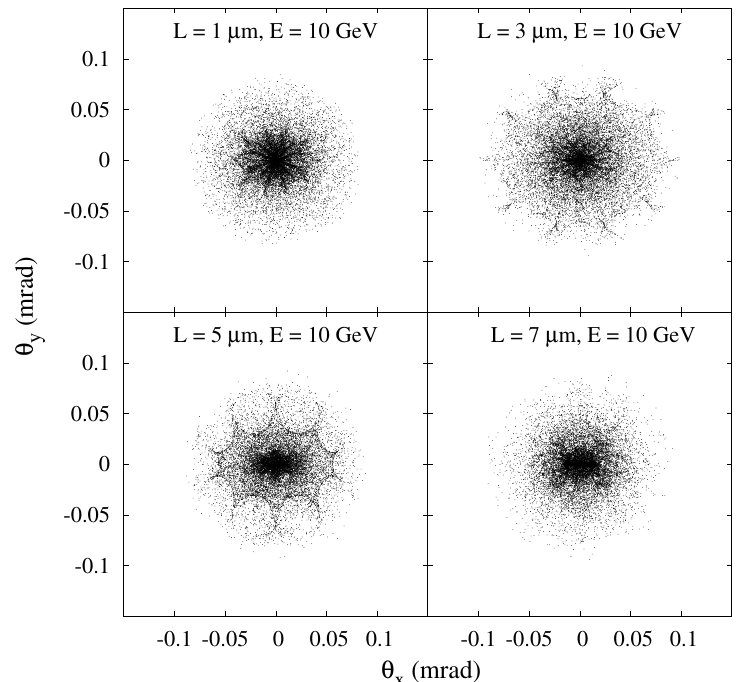
Figure 10. The angular distributions of protons channeled in the radially deformed DWNTs(10, 0)@(5, 0) for different nanotube lengths: (left top) L = 1 µ m; (right top) L = 3 µ m; (left down) L = 5 µ m; (right down) L = 7 µ m, respectively. The radial strain is η = 0.1 and the proton energy is E = 1